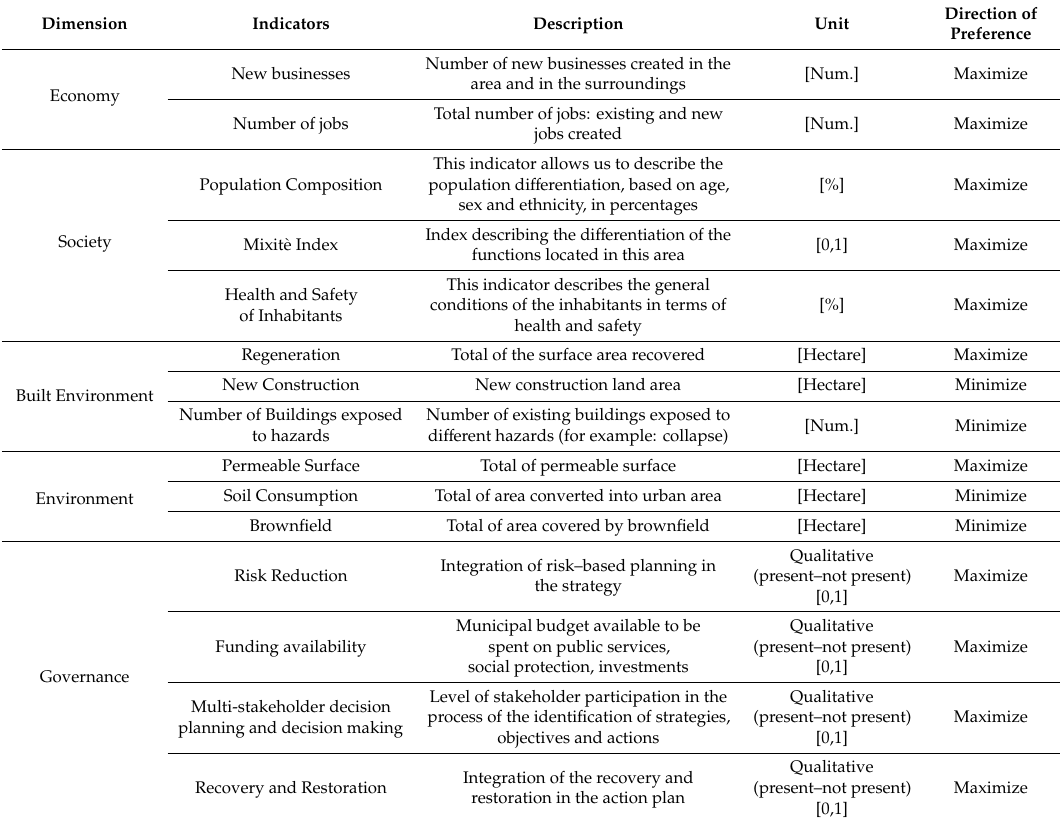
Table 2. Urban Resilience variables for the SDM (Datola et al.,